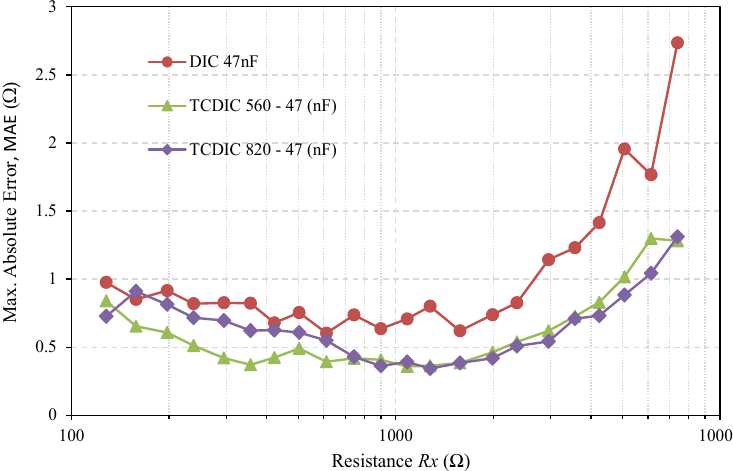
Figure 7. The maximum absolute error in estimating Rx using a classic TPCM DIC, with C = 47 nF (red curve), and the same two TCDIC configurations as shown in Figures 5 and 6. Table 2. The table shows the sum of the Maximum Absolute Errors for each capacitor configura- tion.